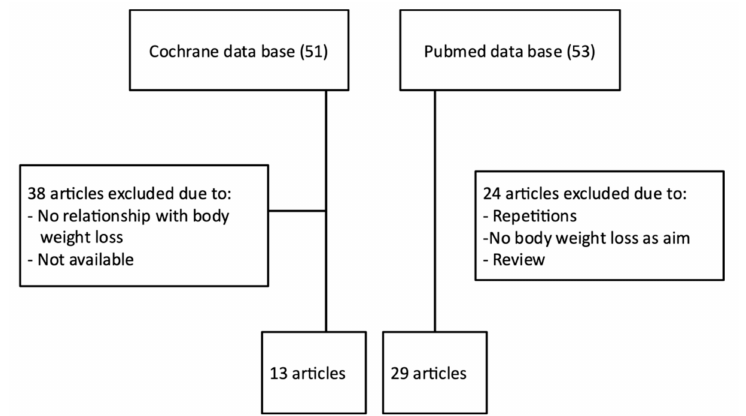
Figure 1. Flow chart showing the process for the inclusions of